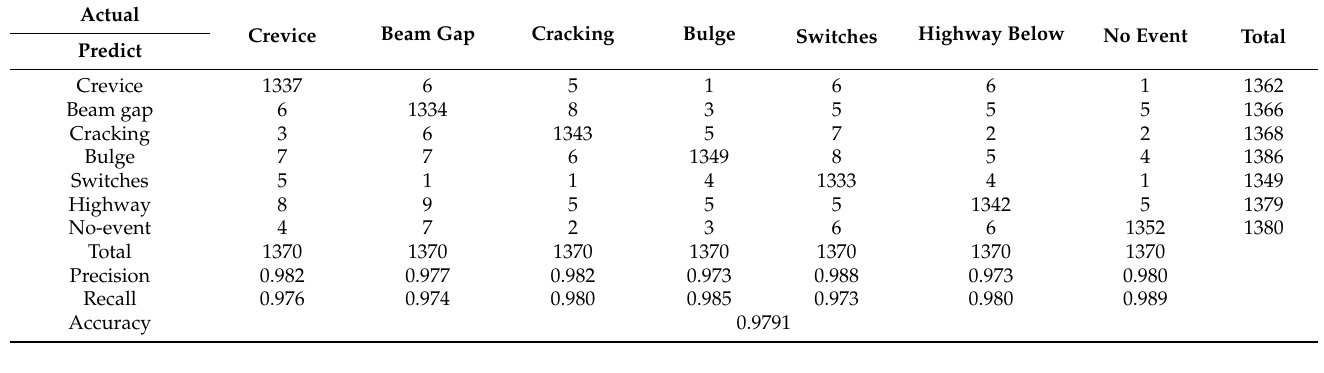
Table 8. Confusion matrix for testing.